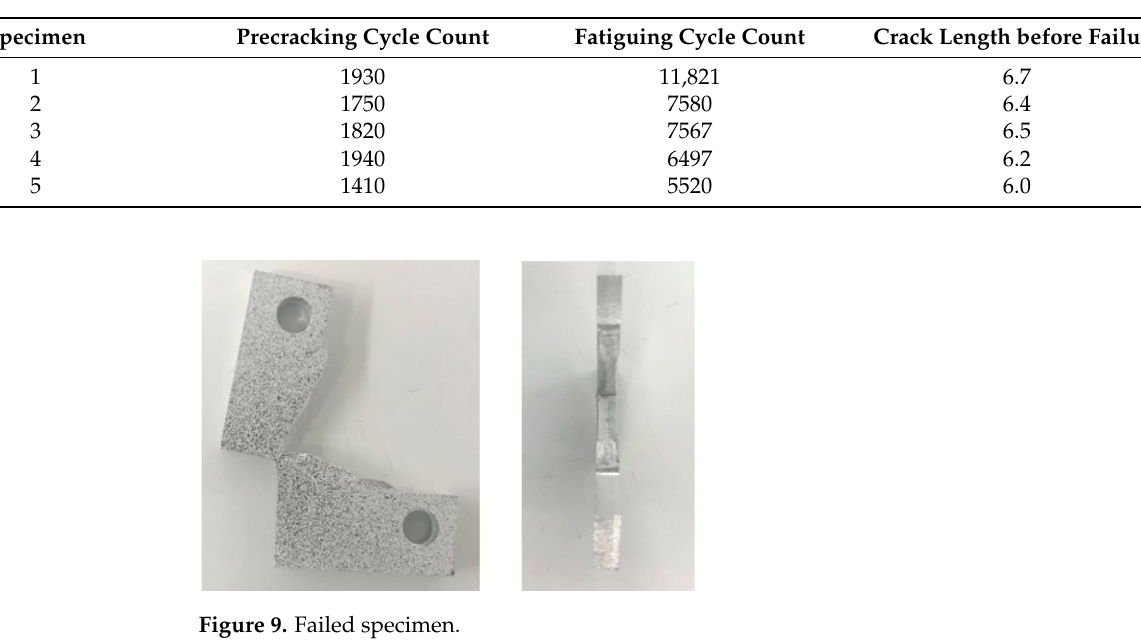
Table 1. Results of fatigue test.